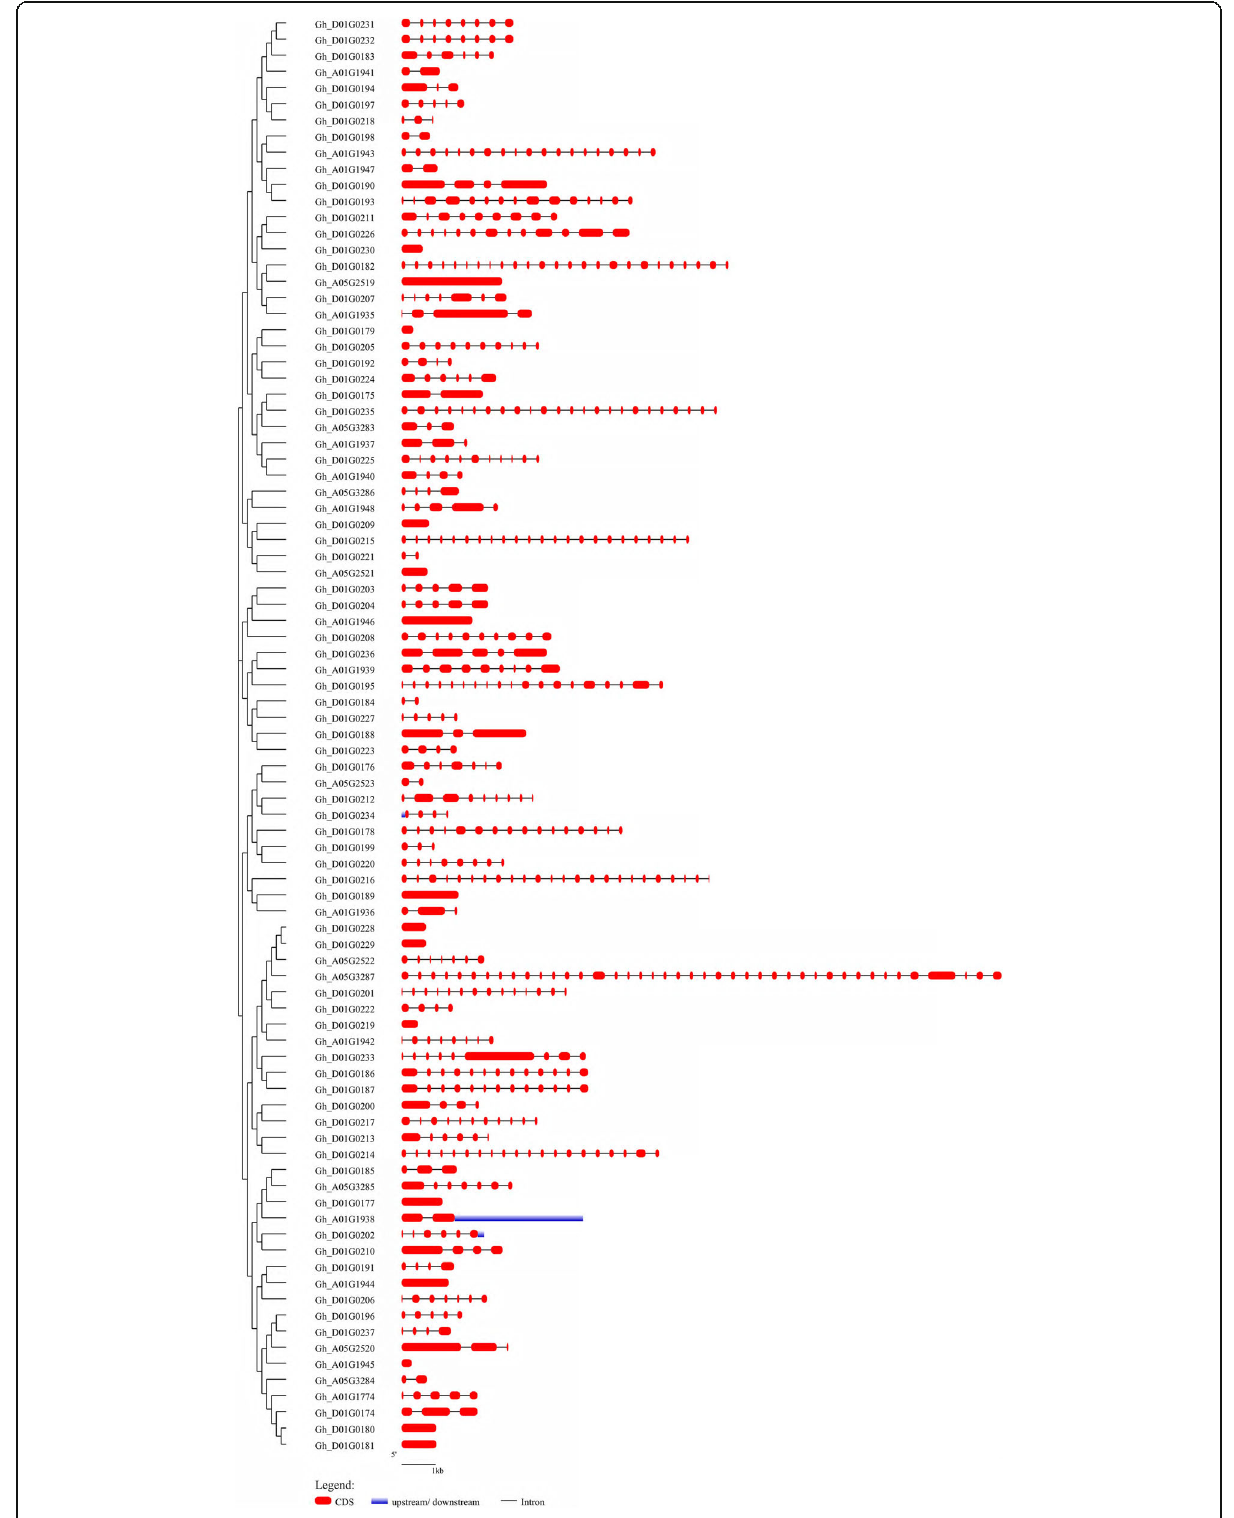
Fig. 3 Phylogenetic tree, and gene structure of the mined genes. The phylogenetic tree was constructed using MEGA 7.0. Exon/intron structures of the genes in upland cotton, exons introns and up/down-stream were represented by red boxes, black lines and blue boxes,